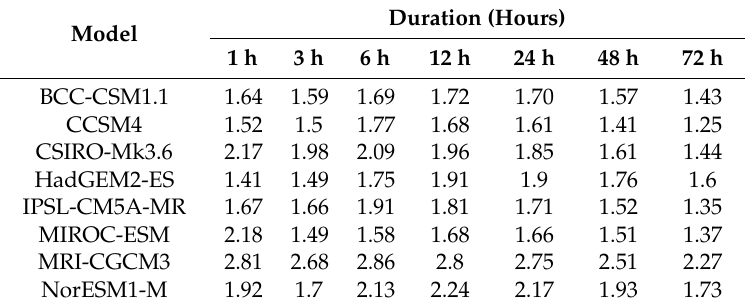
Table 7. Average of the ratios of modelled to observed rainfall intensities of return periods 2, 5, 10, 25, 50, and 100 years for various GCMs at Kedah for RCP